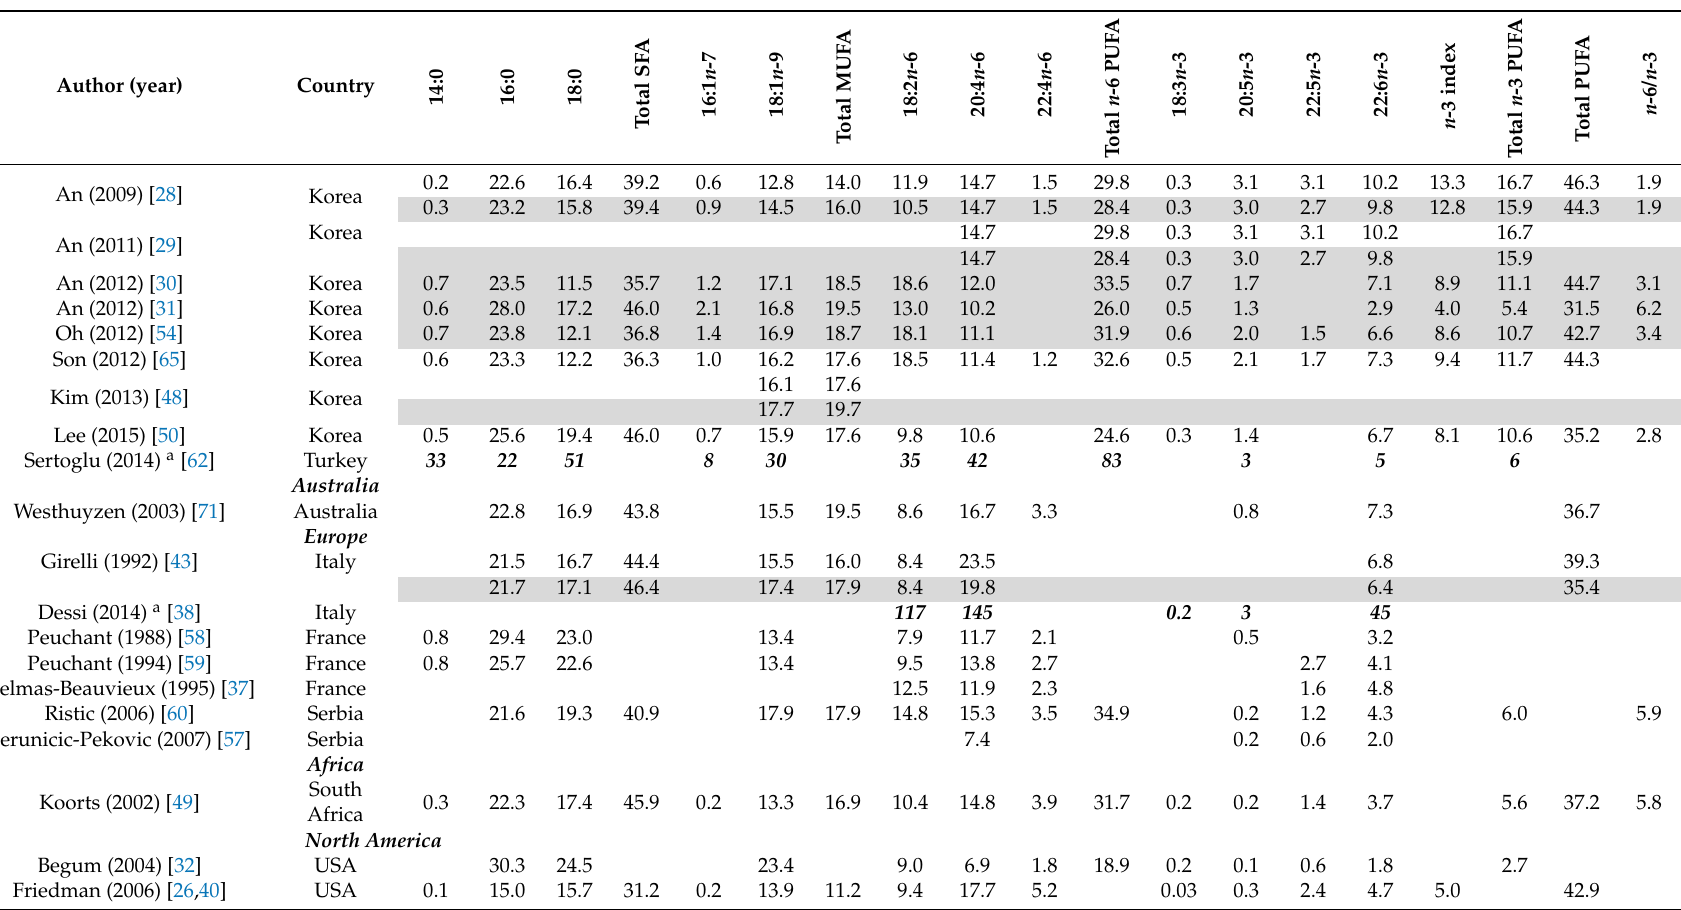
Begum (2004) [32] Friedman (2006) [26,40] Data highlighted in grey represents FA profile of PD patients alone or combining of HD and PD patients, a Data is in µ g/mL (bolded and italicized), b Data is presented as median. Abbreviations: MUFA, monounsaturated fatty acid; n -3 PUFA, omega-3 polyunsaturated fatty acid; n -6 PUFA, omega-6 polyunsaturated fatty acid; NL, the Netherlands; PUFA, polyunsaturated fatty acid; SFA, saturated fatty acid; USA, United States of America. Fatty acid abbreviations: 14:0, myristic acid; 16:0, palmitic acid; 16:1 n -7, palmitoleic acid; 18:0, stearic acid; 18:1 n -9, oleic acid; 18:2 n -6, linoleic acid; 18:3 n -3, α -linolenic acid; 20:4 n -6, arachidonic acid; 20:5 n -3, eicosapentaenoic acid; 22:4 n -6, adrenic acid; 22:5 n -3, docosapentaenoic acid; 22:6 n -3, docosahexaenoic